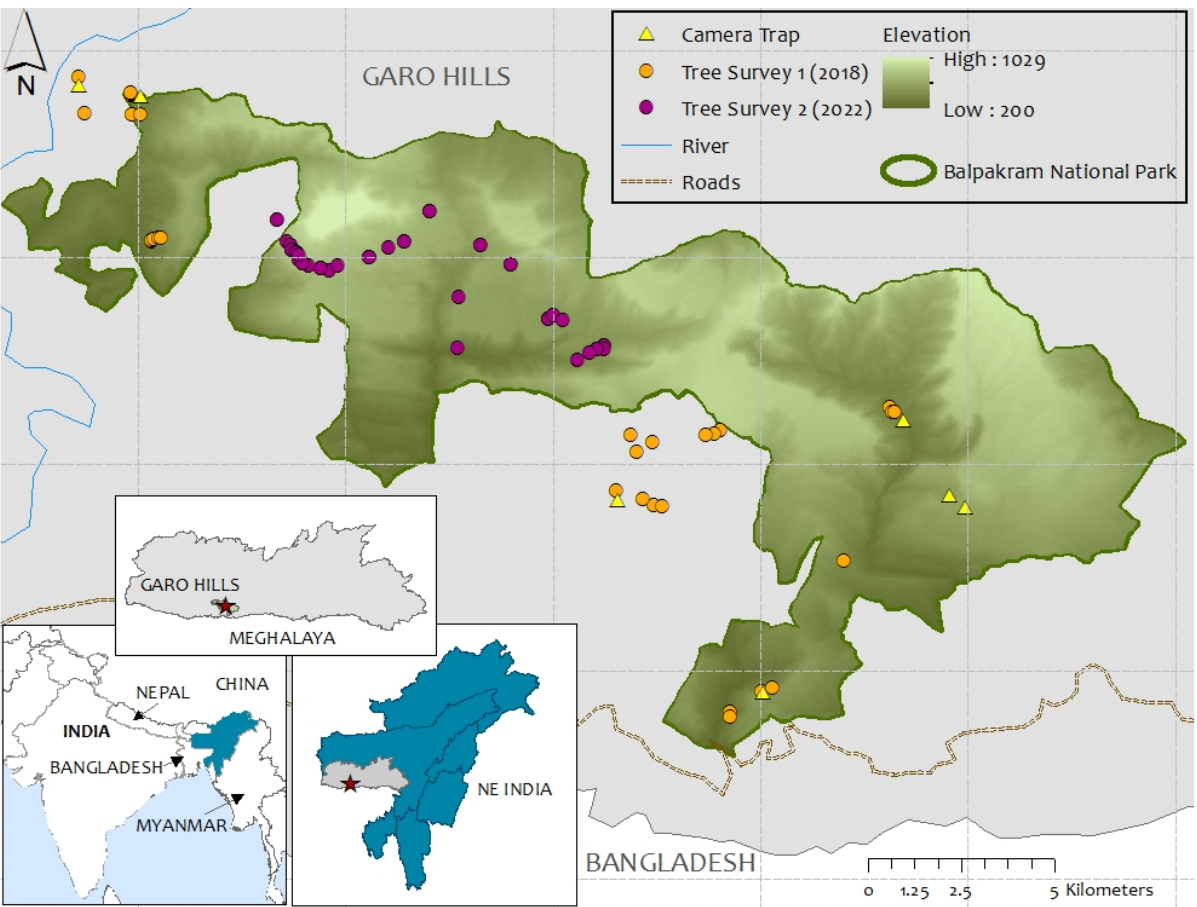
Figure 2. Sites where bear claw-marked trees were found and camera traps set (no bears photo- graphed) in and around Balpakram National Park (star), Meghalaya, India, 2018–2019, and 2022.